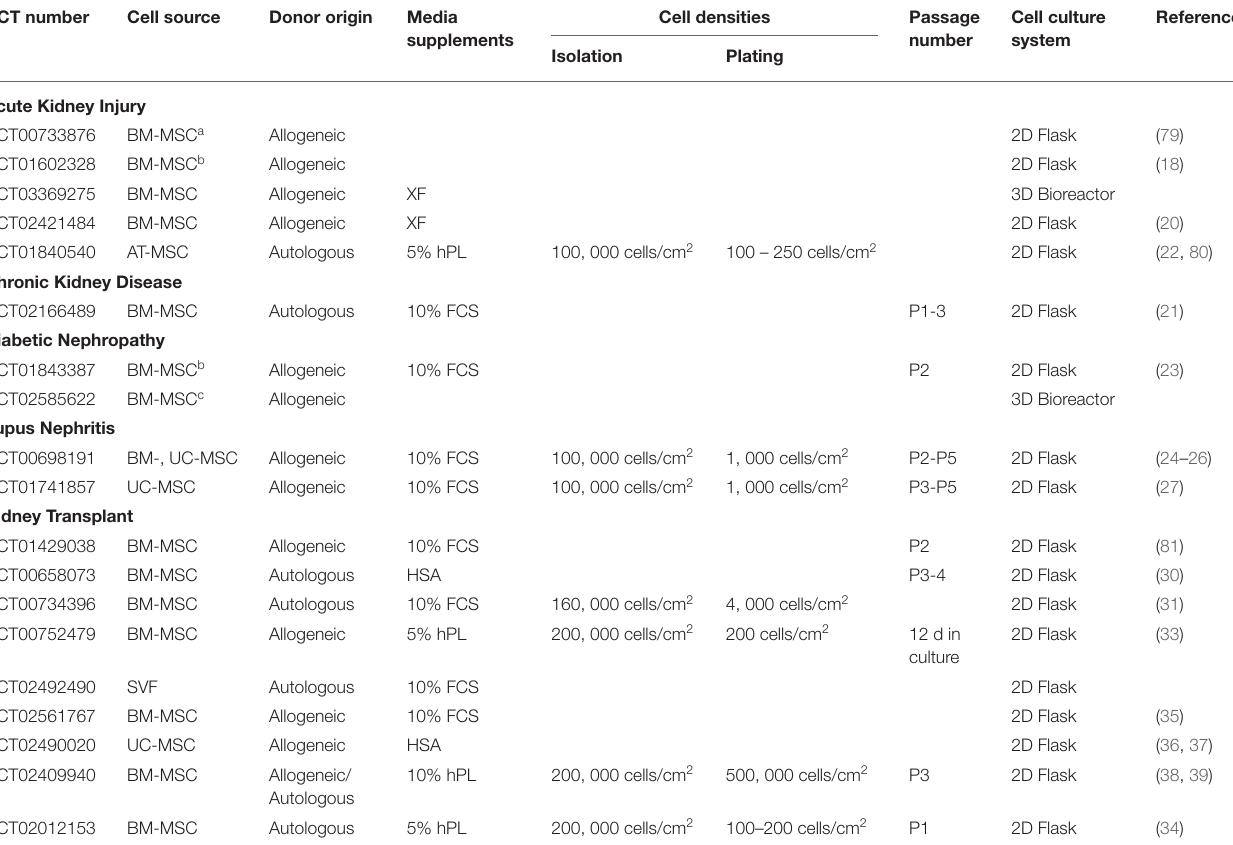
TABLE 2 | Summary of MSC culture processing variables publicly available from clinical trials of